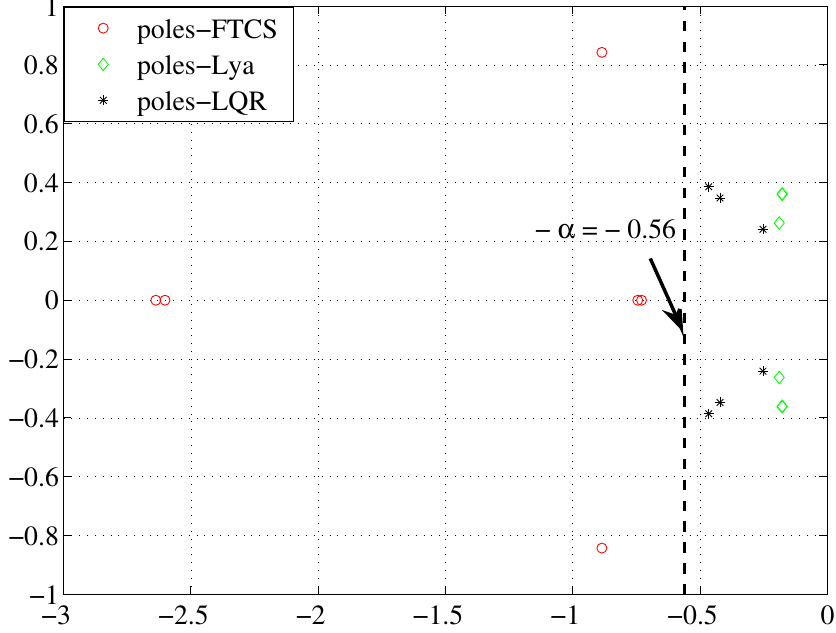
Figure 9. Distribution diagram of pole points from input u 1 to all